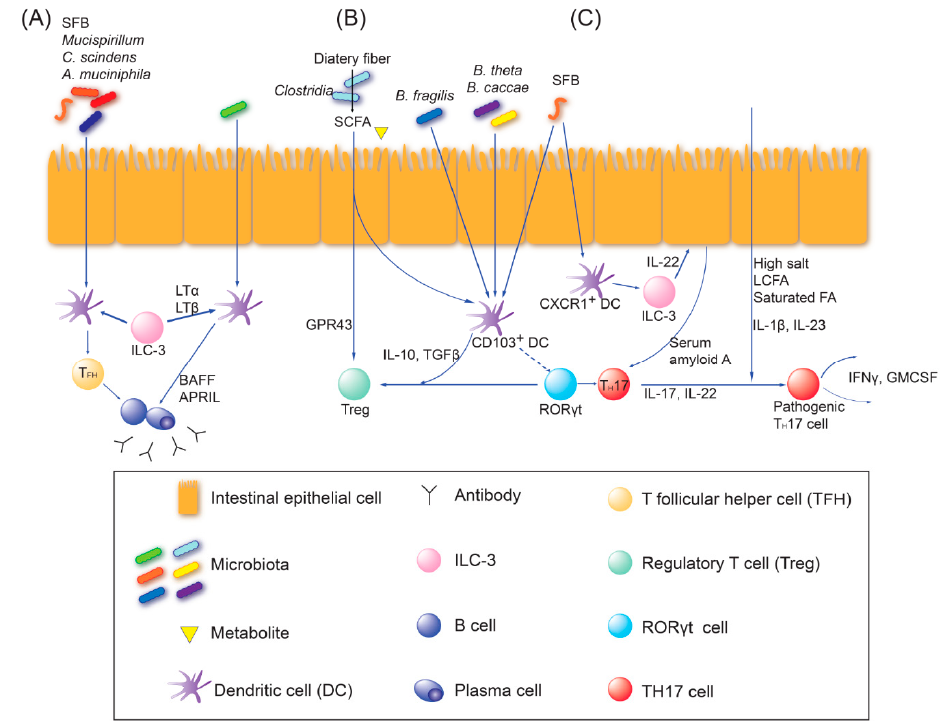
Figure 2. The major interplay pathways between gut microbiota and adaptive immune cells. ( A ) Ig A-producing plasma cells are activated by T follicular helper (T FH ) cell-dependent or T FH cell-independent pathways. Segmented filamentous bacteria (SFB), Mucispirillum , Clostridium scindens , and Akkermansia muciniphila can generate T FH cell-dependent- Ig A + plasma cells. Microbiota-primed group 3 innate lymphoid cells (ILC-3s) interact with dendritic cells (DCs) through Lymphotoxin (LT) α and LT β . The activated DCs promote T FH cell-independent Ig A production mediated by B-cell activating factor (BAFF) and a proliferation-inducing ligand (APRIL). ( B ) Regulatory T (T reg ) cells can